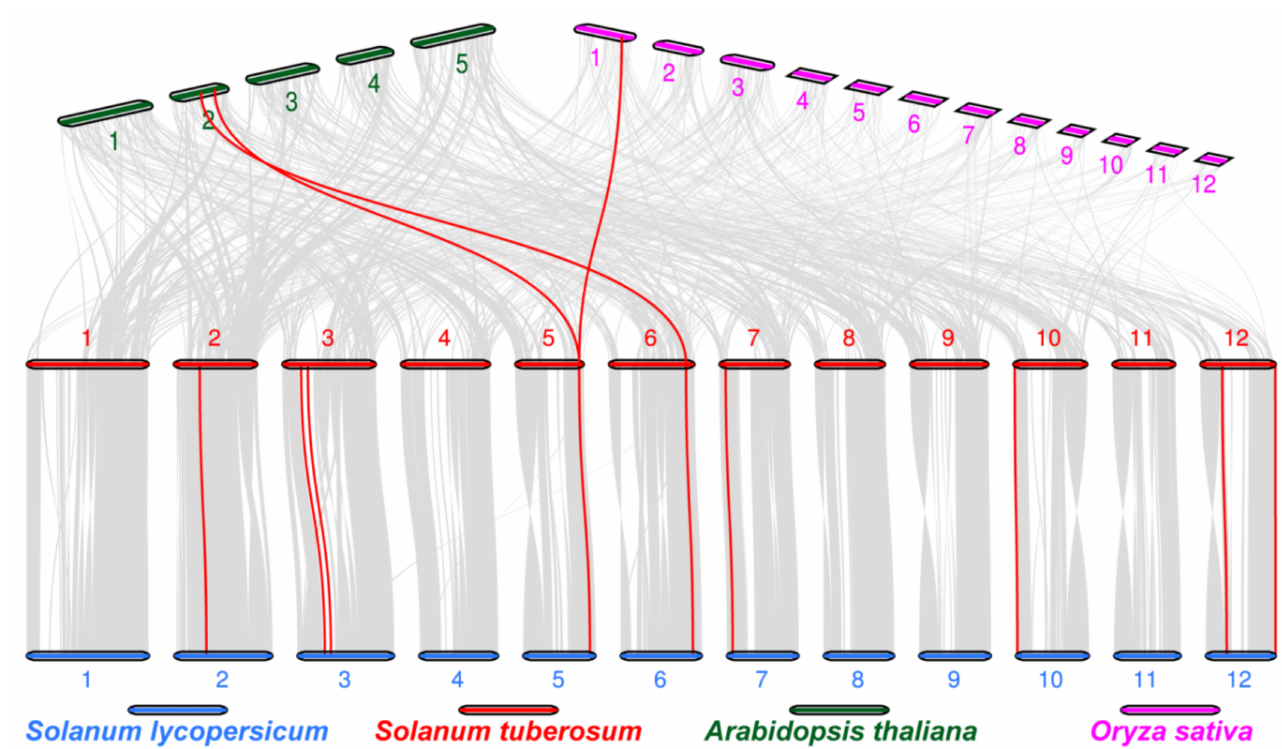
Figure 2. Collinearity analysis of the MTPs in Arabidopsis thaliana, Oryza sativa, Solanum lycopersicum , and Solanum tuberosum . Different colors represent chromosomes of different species, and the number of each chromosome is labeled at their top or bottom. The gray lines indicate the collinear block of genome of the plants and the red line indicates the synonymous MTP gene pairs in